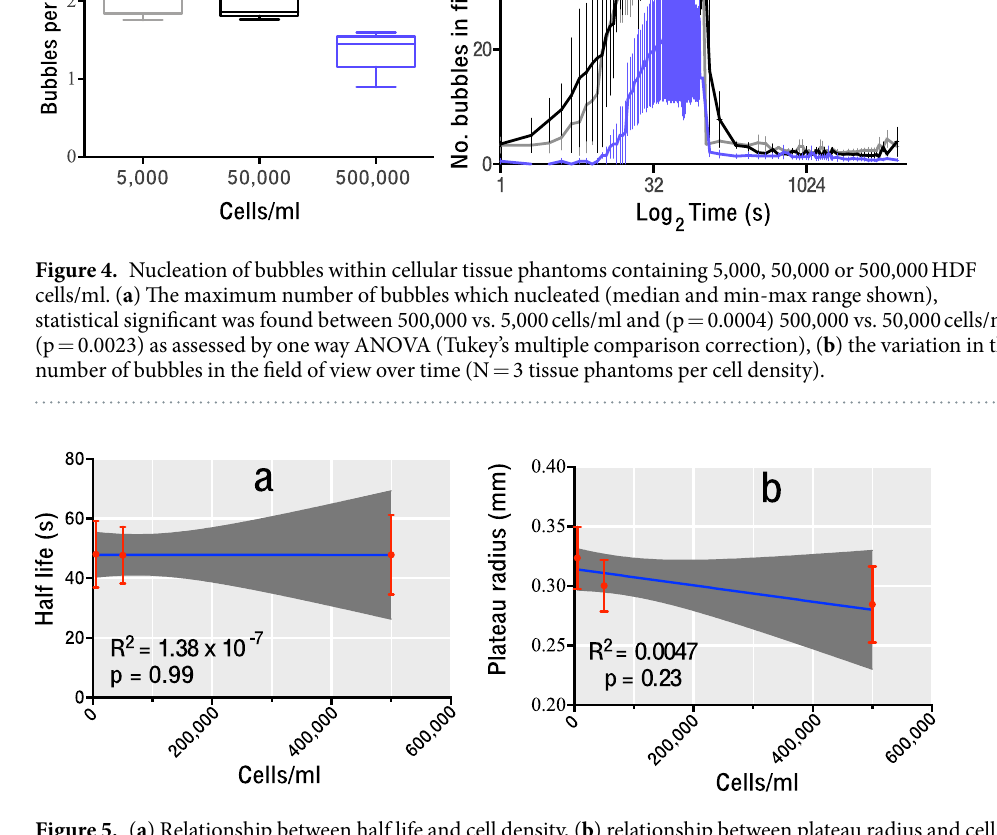
Figure 5. ( a ) Relationship between half life and cell density, ( b ) relationship between plateau radius and cell density, mean and 95% confidence intervals shown for points and for the linear regression fit. R 2 and p-values of the linear regression given on each graph. No statistical dependence was found for either measured variable with varying cell